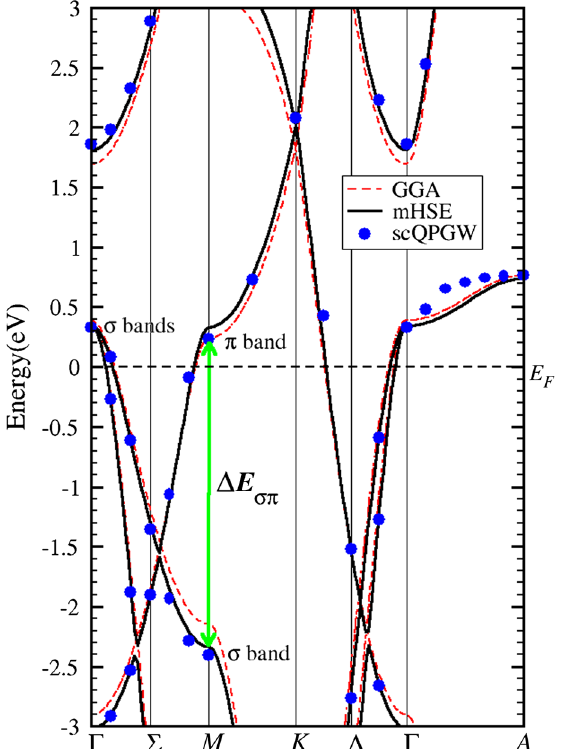
FIG. 10. Density of states of MgB scQP GW , the DFT mHSE, the DFT HSE06, and the DFT FIG. 9. Band structure of MgB , calculated by the DFT GGA, GGA and compared to experiments [109]. For each DOS of 2 the DFT mHSE06, and the scQP GW . The DFT mHSE ( (cid:3) ¼ 0 : 6 ) all the data, an arrow is drawn to indicate the peak position, band structure agrees well with that calculated by the scQP GW , which is mainly contributed by the B 2 p states. The DOS of the with a splitting of the (cid:9) band and (cid:10) band at the M point (i.e., scQP GW method, the DFT mHSE ( (cid:3) ¼ 0 : 6 ), and experiments ) about 2.6 eV, in good agreement with experiments [91]. (cid:5) E [109] share a common peak at about (cid:1) 2 : 4 eV , whereas the DFT (cid:10)(cid:9) by about The DFT GGA underestimates this splitting (cid:5) E GGA underestimates this peak position by 0.2 eV (at about (cid:10)(cid:9) (cid:1) 2 : 2 eV ) and the DFT HSE06 overestimates it by 0.4 eV (at 0.2 eVand overestimates the size of the (cid:10) Fermi surface centered at the (cid:2) point. about (cid:1) 2 : 8 eV